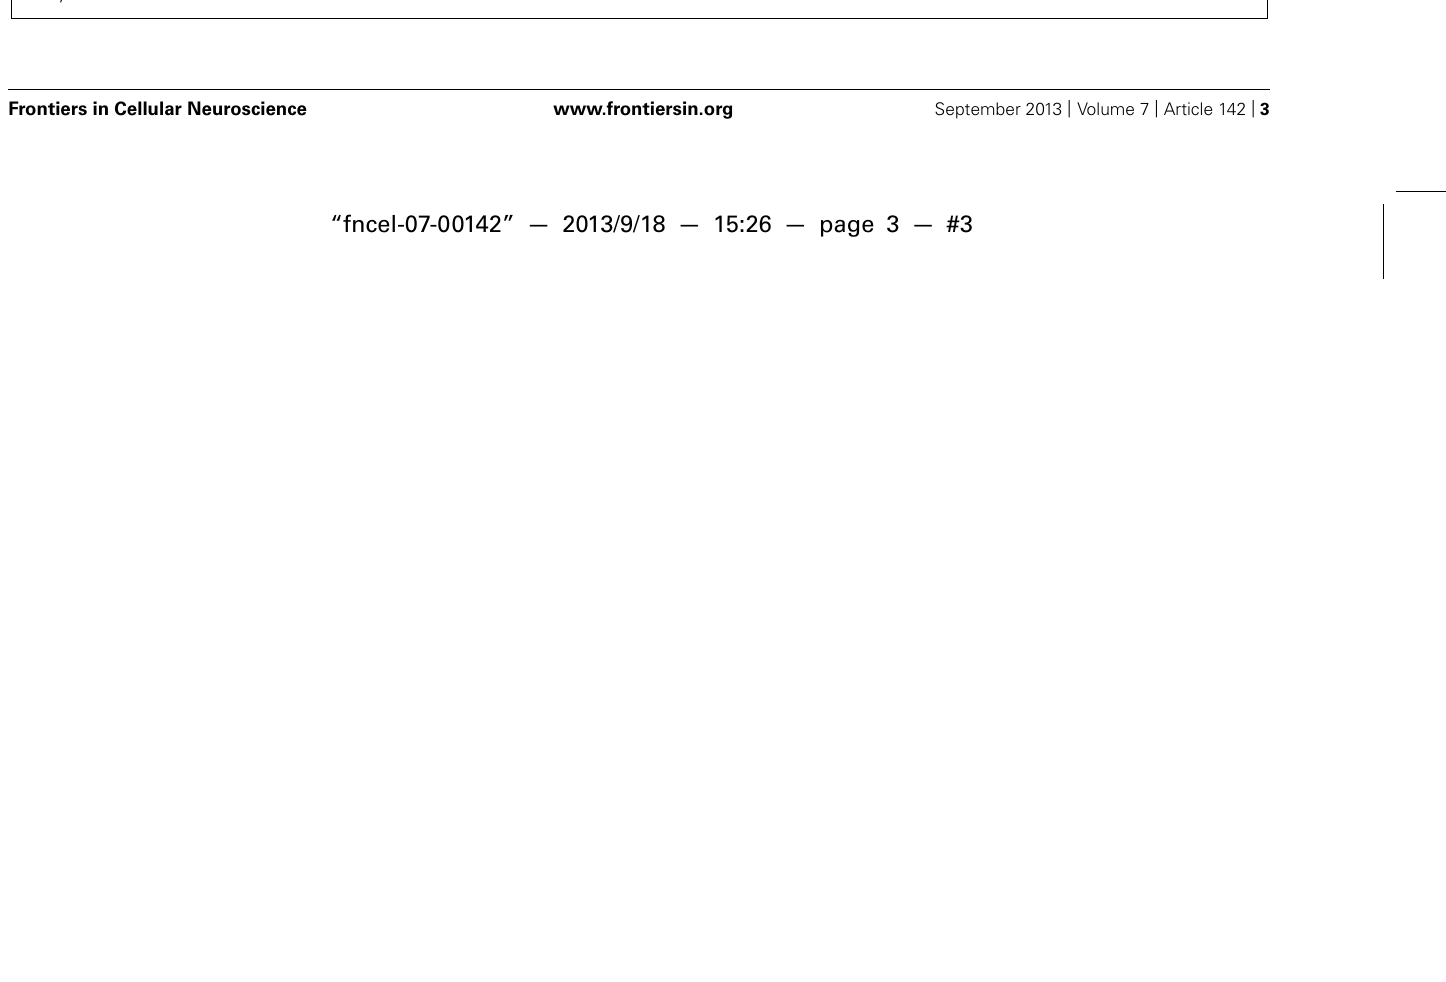
FIGURE 1 | Flow Diagram. The diagram shows that 104 participants were initially screened for the studies and finally 78 participants were included in the data analysis.